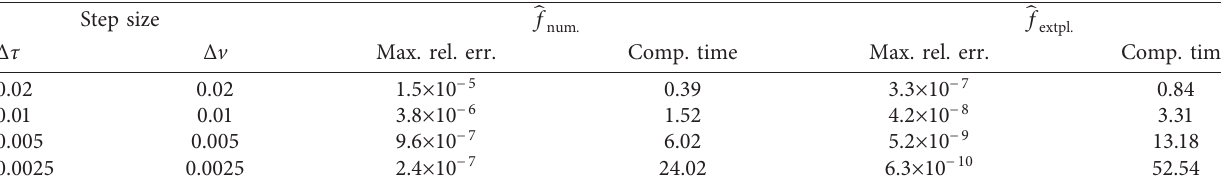
and 􏽢 f in the domain 0 ≤ τ ≤ 100 and 0 ≤ num . extpl .